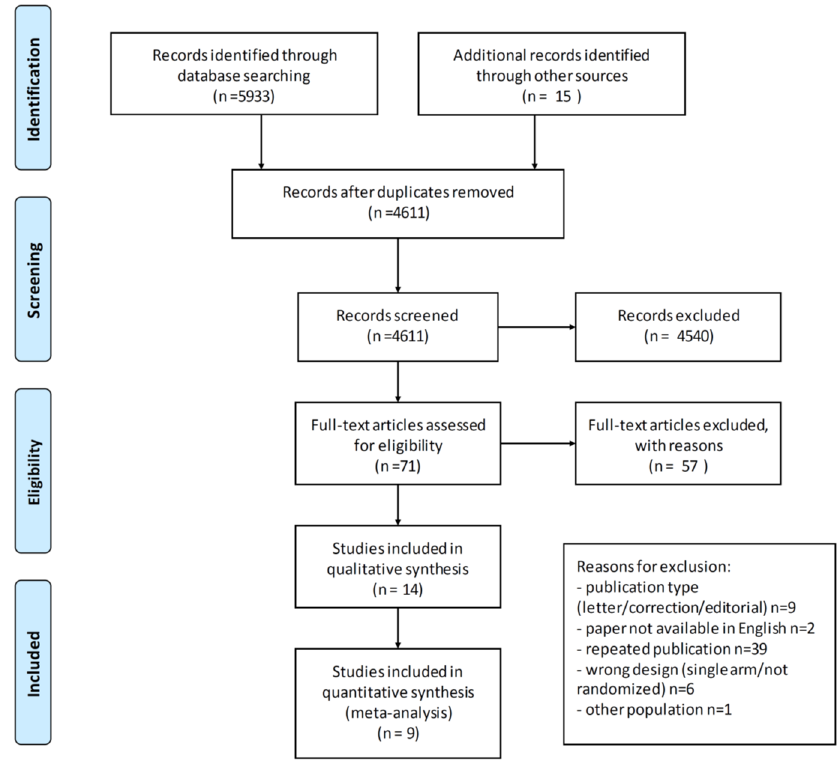
Figure 1. PRISMA flowchart of study selection. From: Moher D, Liberati A, Tetzlaff J, Altman DG, The PRISMA Group (2009). Preferred Reporting Items for Systematic Reviews and Meta-Analyses: The PRISMA Statement. PLoS Med 6(7): e1000097. doi:10.1371/journal.pmed1000097 .